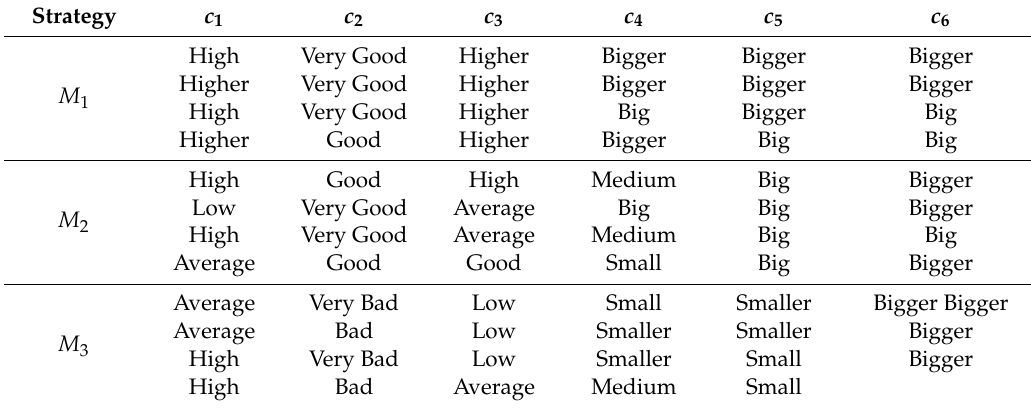
Table 2. Evaluation results of qualitative index c 1 – c 6